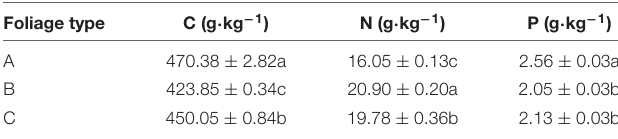
TABLE 6 | Initial foliar chemical characteristics of Taxodium distichum (A), Salix matsudana (B), and their mixtures (C). Foliage